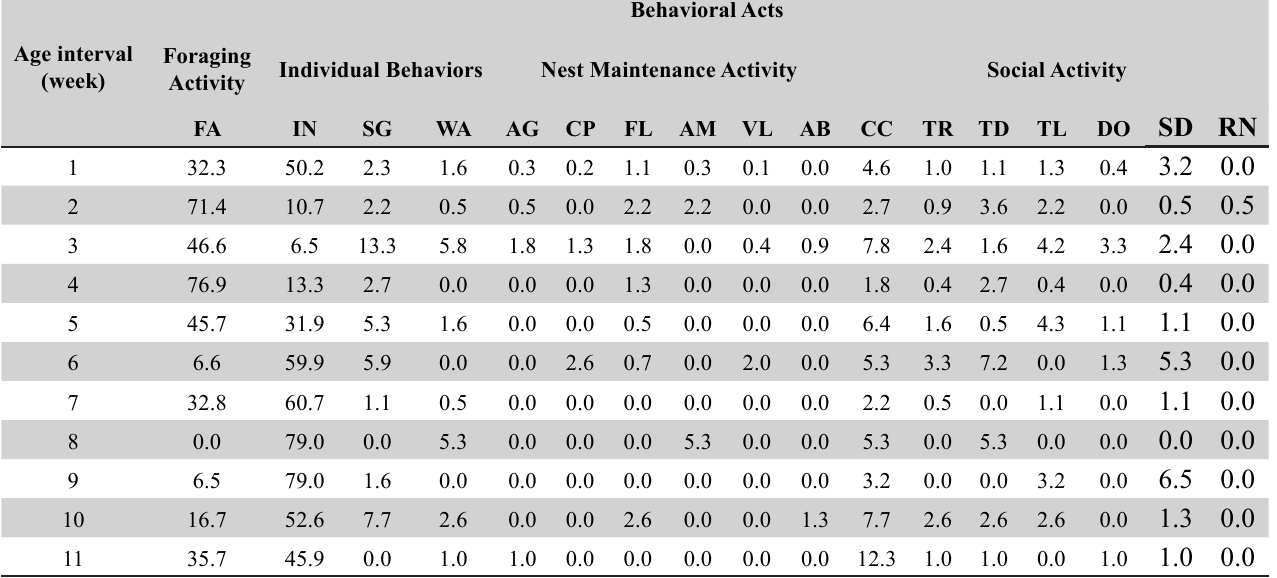
Table 2 . Frequency (%) of behaviors performed by workers of Mischocyttarus latior (Fox, 1898) at intervals of weeks.